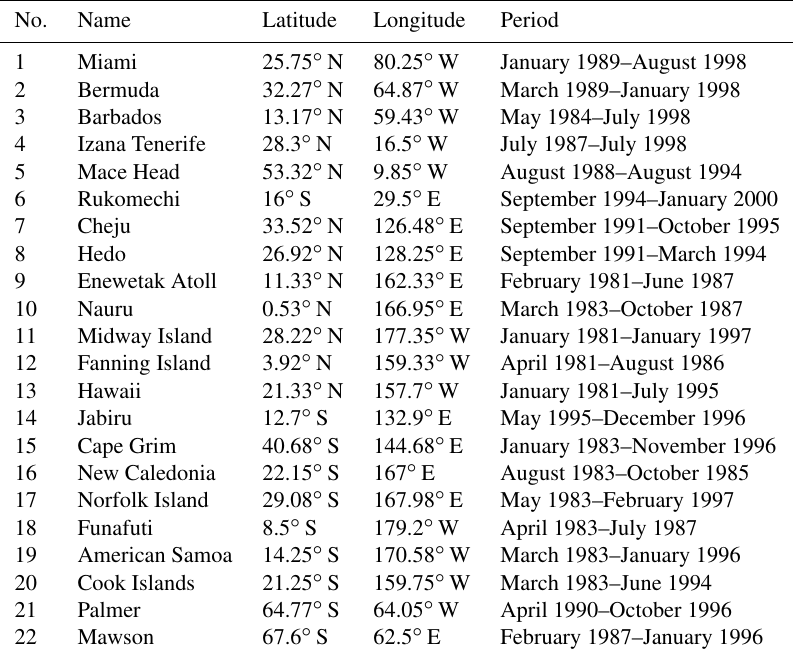
Table 2. The location of observational stations for surface dust concentration used in this study. No. Name Latitude Longitude